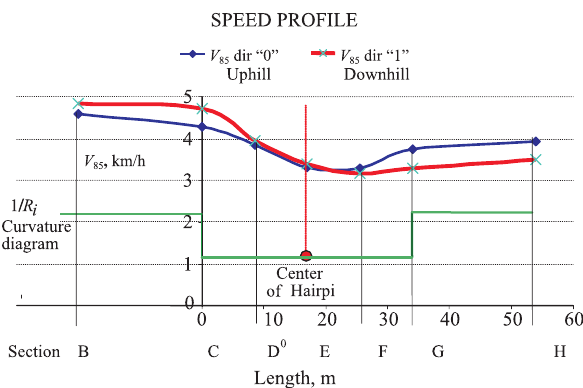
Fig. 7. Model 1 V